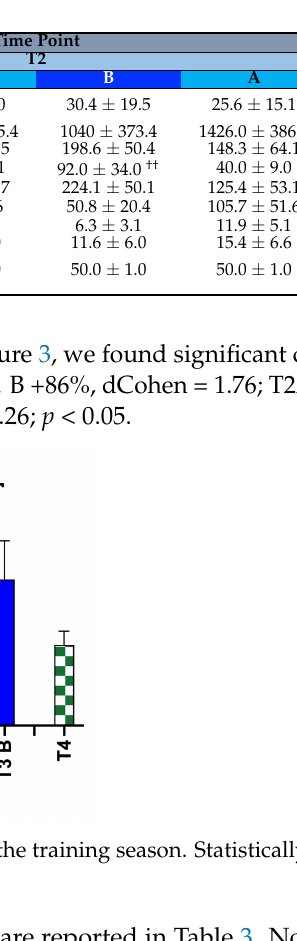
Table 3. Urine standard analysis. Urine test strip data values (mean ±SD) from all subjects. The colors of the time boxes (from T0 to T4), are the same as those reported in the histograms of figures from 2 to 4, to help the reader.